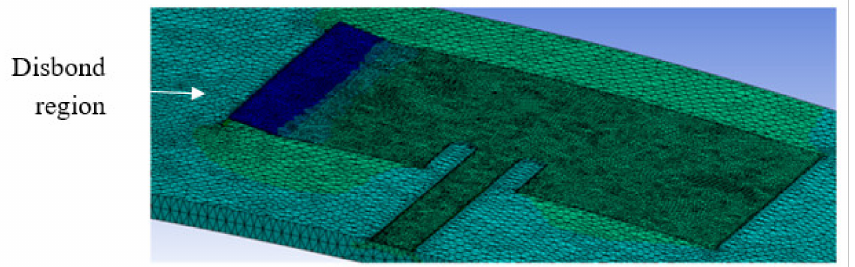
Figure 16. CLAS specimen loaded under tension, with the disbonded region elevated and coloured in dark blue.